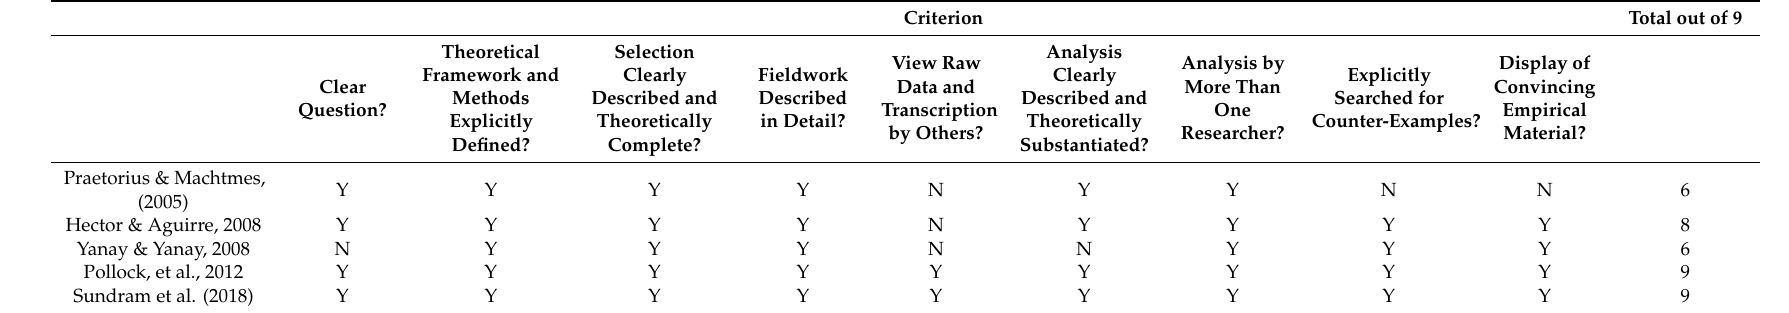
Table A2. Quality assessment for all included qualitative studies, in order of year of publication ( n =